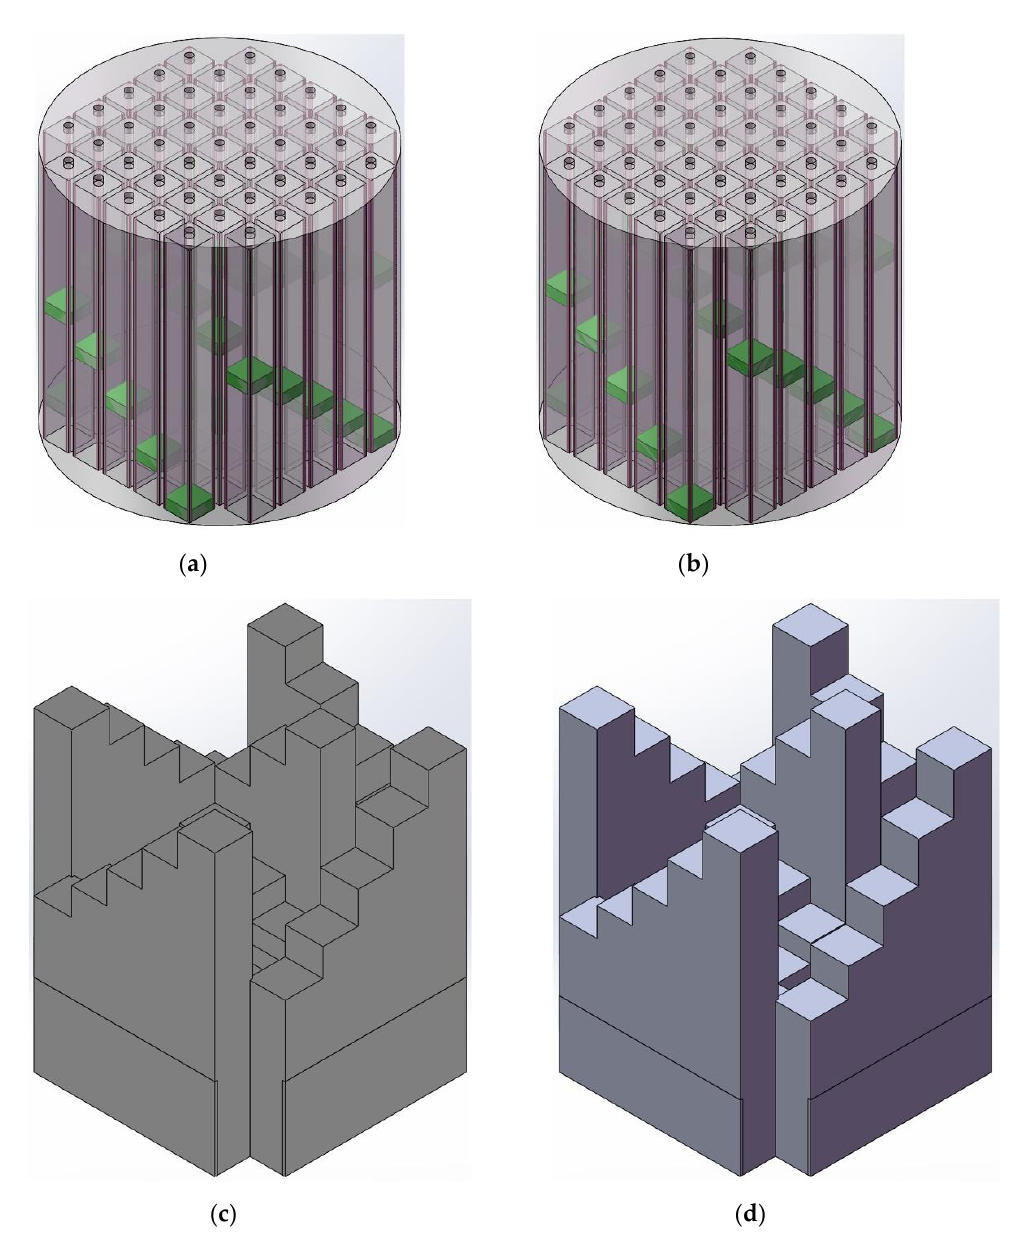
16 of 27 Figure 9. The transfer function tube measurement with detector of AWA6290T. ( a ) A schematic di- agram; ( b ) an actual photo. Meanwhile, in order to avoid interference with the measurement process, the adjust- ment of length of the cavity by moving the slider along the guide in chamber driven by the linear actuator was conducted outside, and the well-tuned APH-AM was placed in the AWA6290T detector to measure. By the multiple optimization process consisted of alternate adjustment and measure- ment according to the program proposed in the Section 2.3 and exhibited in the Figure 8, the desired APH-AM samples for the two targets was obtained, which were exhibited in the Figure 10, and the optimized length of the cavity for each chamber were summarized in the Table 5. Taking the control accuracy of the length of the cavity into consideration, the values of optimized length of the cavity for each chamber in the 2 desired APH-AM samples were kept one decimal place. It could be found that the minimal length of the cavity for the target of all the sound absorption coefficients above 0.9 was 25.6 mm and that for the target of all the sound absorption coefficients above 0.85 was 20.2 mm. More- over, its corresponding sound absorption performance was analyzed and the absorption mechanism was investigated by acoustic finite element simulation in the following section. Table 5. The summary of the optimized length of the cavity for each chamber in the desired APH- AM samples.